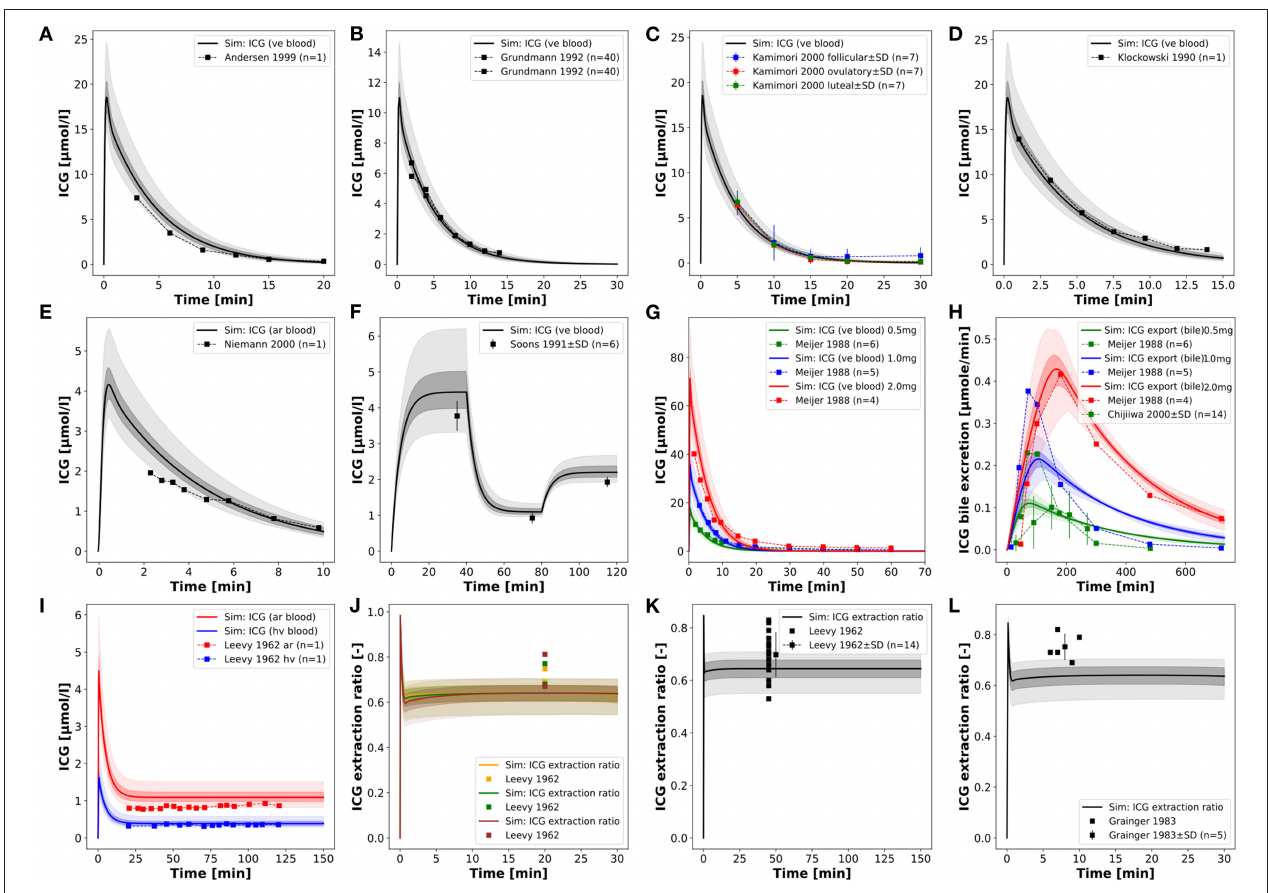
FIGURE 2 | Model prediction of ICG time courses in healthy subjects. (A–D) Venous concentration after bolus ICG administration (Klockowski et al., 1990; Grundmann et al., 1992; Andersen et al., 1999; Kamimori et al., 2000). (E) Arterial concentration after bolus ICG administration (Niemann et al., 2000). (F) Venous concentration during an ICG infusion protocol (2.0, 0.5, 1.0 mg/min, 40 min each) ( Soons et al., 1991). (G,H) Venous concentration and biliary excretion rate after 3 different ICG doses (0.5, 1.0, 2.0 mg/kg) ( Meijer et al., 1988; Chijiiwa et al., 2000). (I) Hepatic venous and arterial concentration during constant ICG infusion (Leevy et al., 1962). (J–L) ICG extraction ratio during constant infusion (Leevy et al., 1962; Grainger et al.,